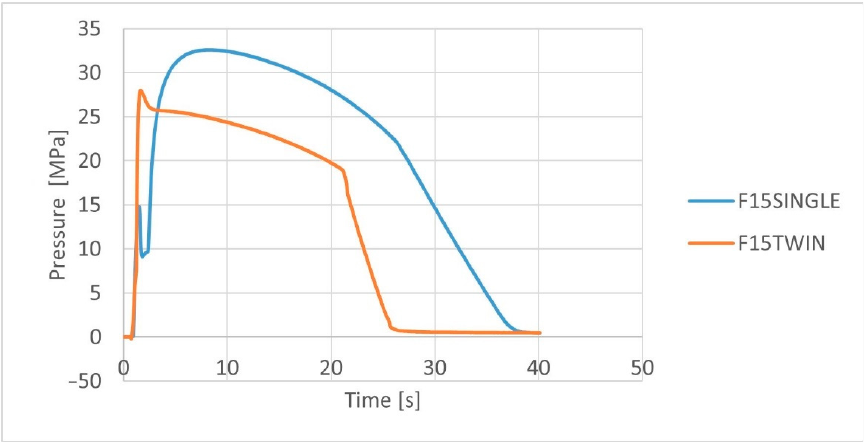
Figure 6. Variation of the cavity pressure for PHBV biocomposites with flax fibers extruded by various methods.